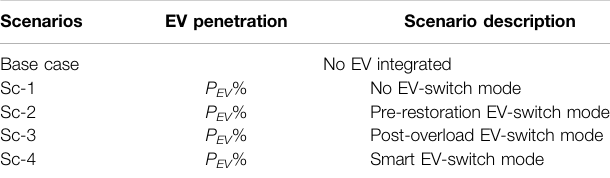
TABLE 5 | Modeling Scenarios of EV impact on the distribution network.